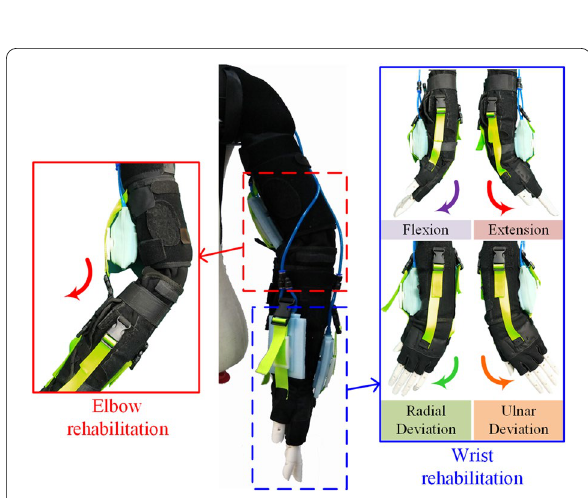
Figure 3 Rehabilitation training of elbow and